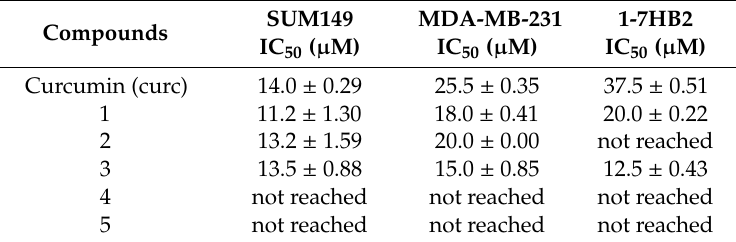
Data are expressed as the concentrations which inhibit 50% (IC 50 ) cell growth and are means ± SE of at least three separate experiments.